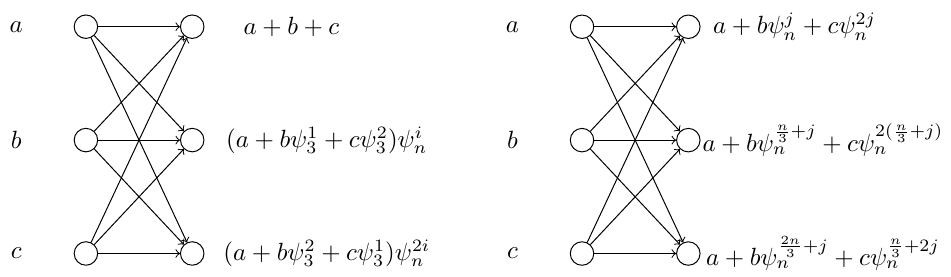
Figure 3: Radix-3 butterfly diagrams for Gentleman-Sande (left) and Cooley-Tukey (right).